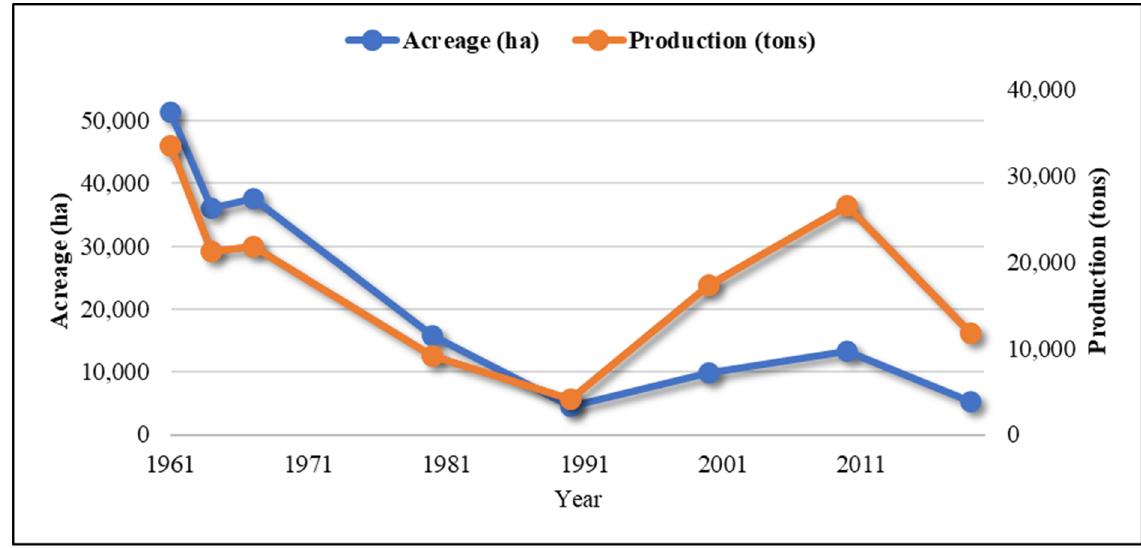
Figure 3. Dry cowpea seed harvested acreage and production in the United States over time. Data were adapted from Food and Agriculture Organization (FAO) database in August 2021.